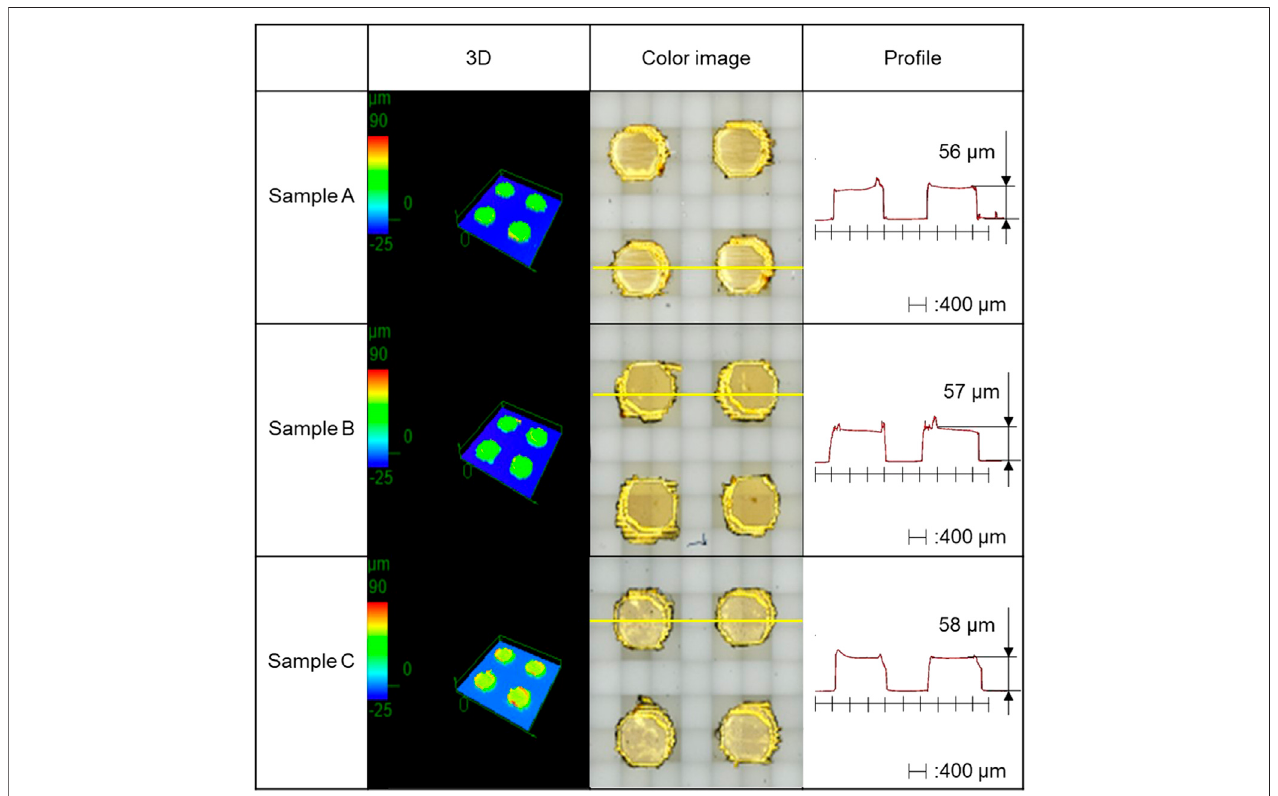
FIGURE 5 | 3D map, color image, and pro fi le of the mask on the glass surface of the MSJ process.